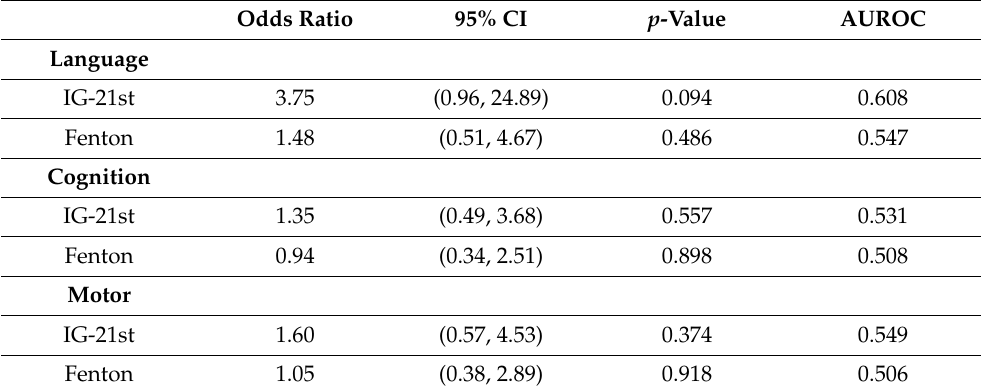
Table 4. Unadjusted analyses of weight-based growth failure as predictor of adverse neurodevelop- mental outcome.